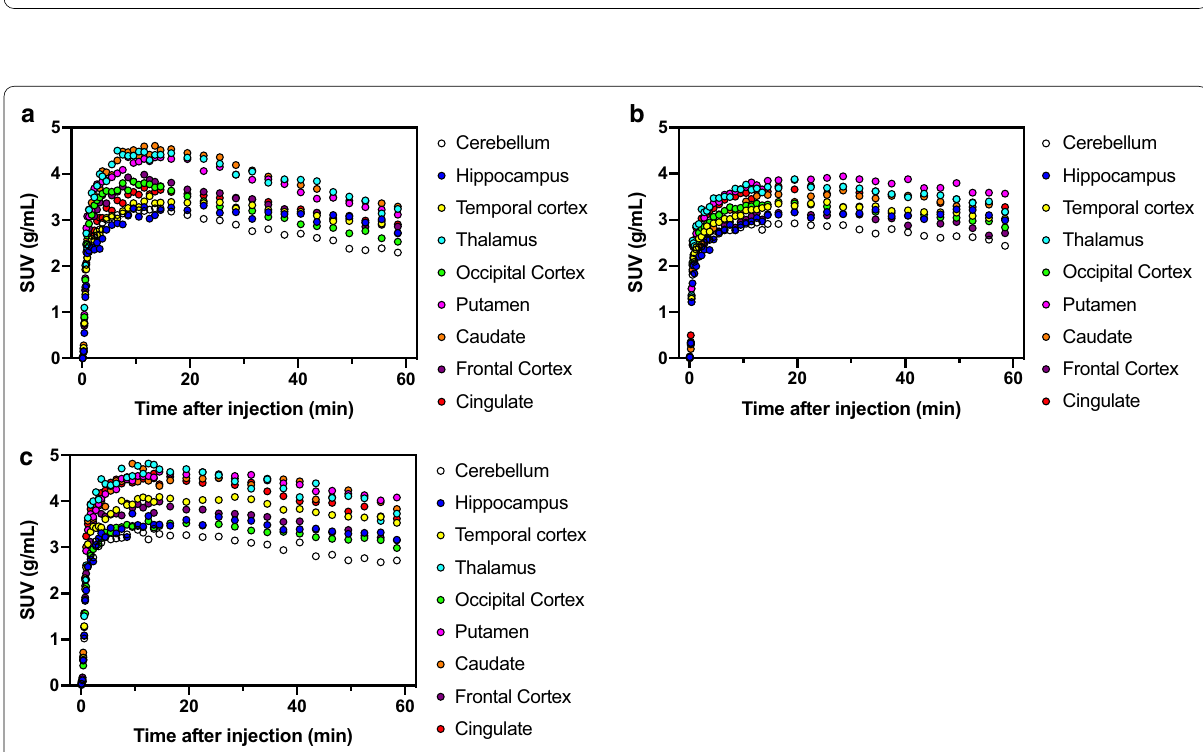
Fig. 4 Decay-corrected TACs of nine brain regions after intravenous injection of [ 11 C] 4 into monkeys pretreated with vehicle ( a ), 10 mg/kg AZM ( b ), and 20 mg/kg AZM ( c ). Nine brain regions were selected to generate tTACs: cerebellum, merged bilateral hippocampus, merged bilateral temporal cortex, thalamus, merged bilateral occipital cortex, merged bilateral putamen, merged bilateral caudate, merged bilateral frontal cortex,